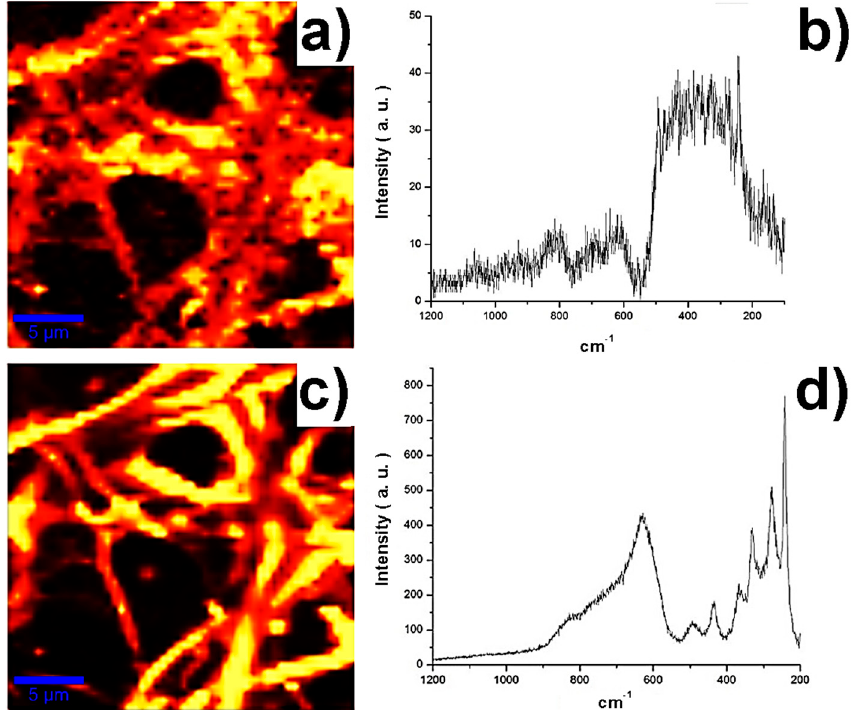
Figure 4. The Raman spectroscopy mapping and Raman spectrum of the LiNbO 3 /SiO 2 coaxial fibers for samples M03 (subsections ( a ) and ( b )) and M05 (sunsections ( c ) and ( d )) sintered at 800 °C.